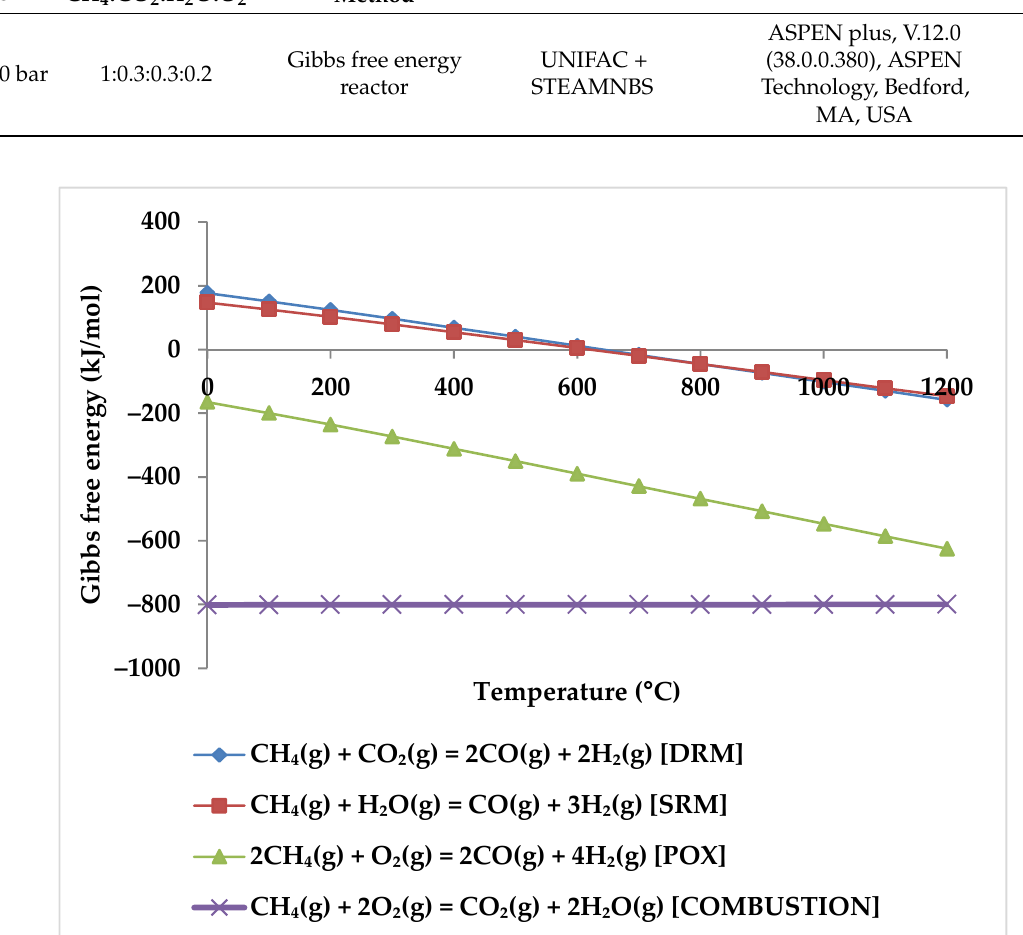
Figure 9. Gibbs free energy diagram for reaction between CH 4 and H 2 O, CO 2 , and O 2.